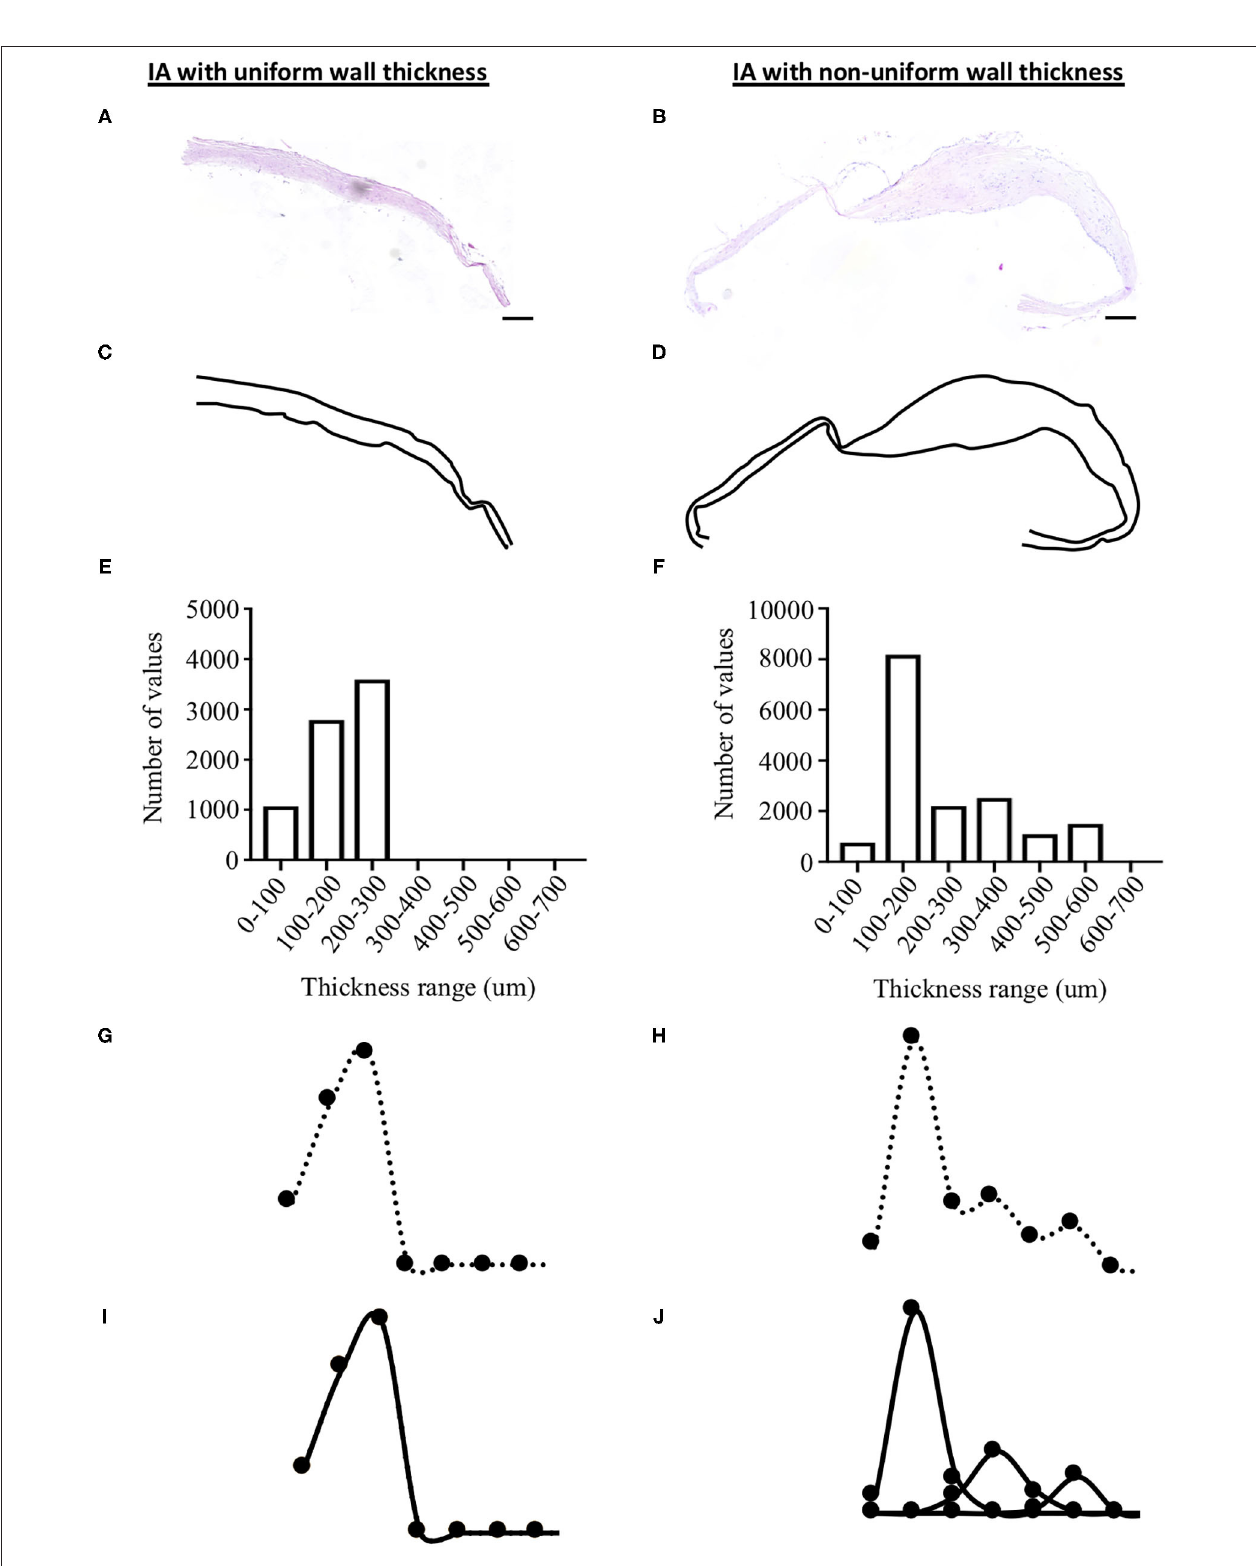
FIGURE 2 | Methods for the measurement of aneurysm wall thickness and thickness uniformity. IA wall thickness was measured on hematoxylin and eosin sections (A,B) after drawing the external border of the IA wall (C,D) . A thickness topographic map of each dome was obtained (E,F) allowing the calculation of a Gaussian curve from this frequency distribution (G,H) . Each Gaussian curve was decomposed (I,J) to classify IA wall as uniform (i.e., 1 Gaussian curve, left side of the figure) or non-uniform (i.e., 2–5 Gaussian curves, right side of the figure). Scale bar in (A,B) = 200 µ m.